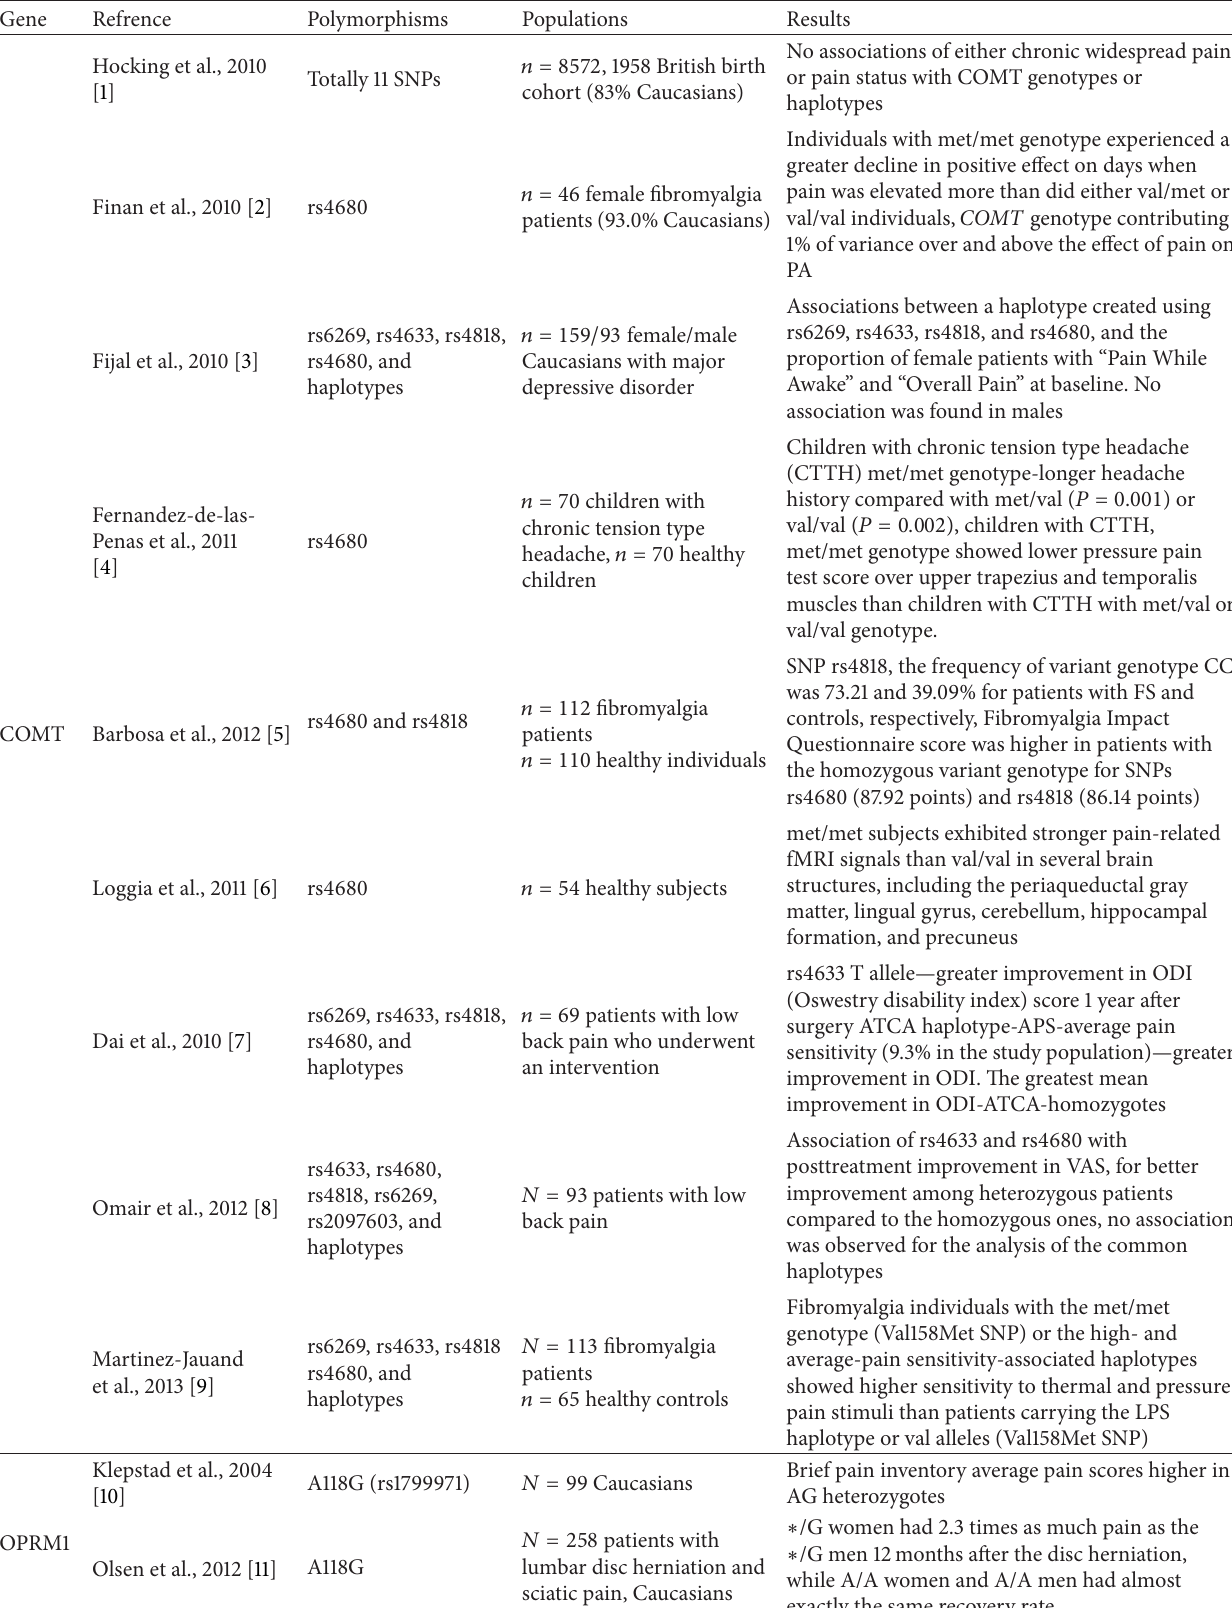
Table 1: Overview of recently released (2010–2012) studies assessing the influence of various gene polymorphisms on pain perception in